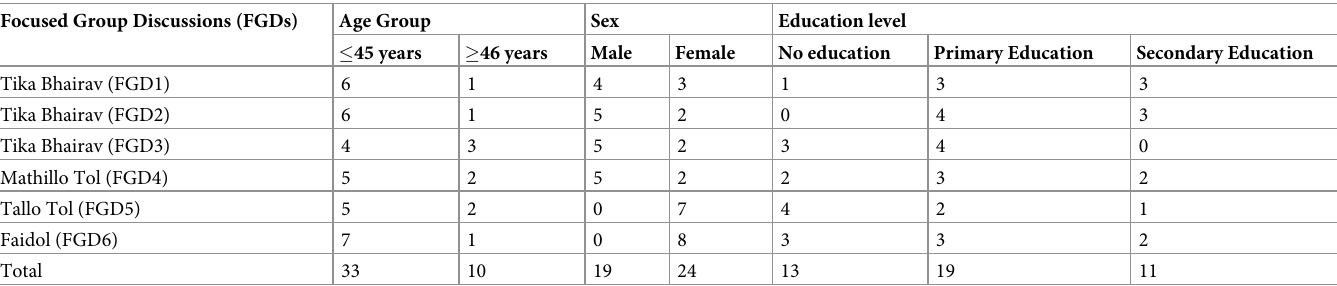
Table 1. Characteristics of participants in focused group discussions (n =